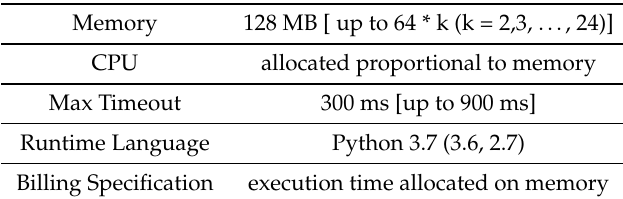
Table 1. Function instance